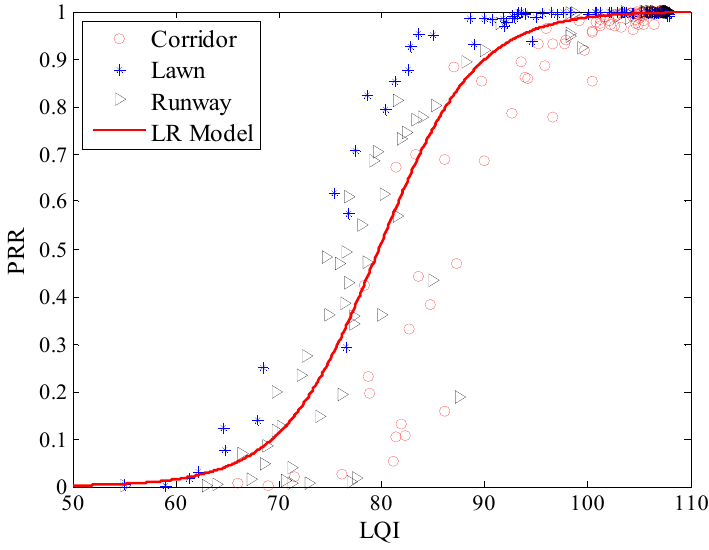
Figure 24. E ff ects of the LR model in di ff erent environments. Figure 24. Effects of the LR model in different environments. Table 6. RMSEs of LQI based mapping model in di ff erent environments. Runway